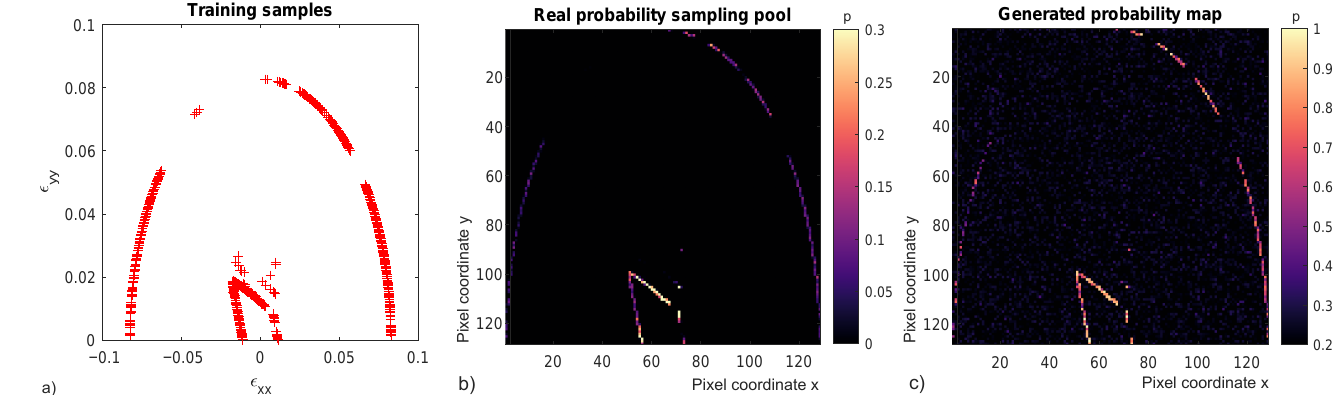
Figure 15. Real data from micro-scale 6 ( a ), real probability sampling pool ( b ) and one generated probability map with GANs ( c ). The three micro-structure fates can be identified in each of the three figures i.e., inner failure surface, diffuse failure region and end of loading without